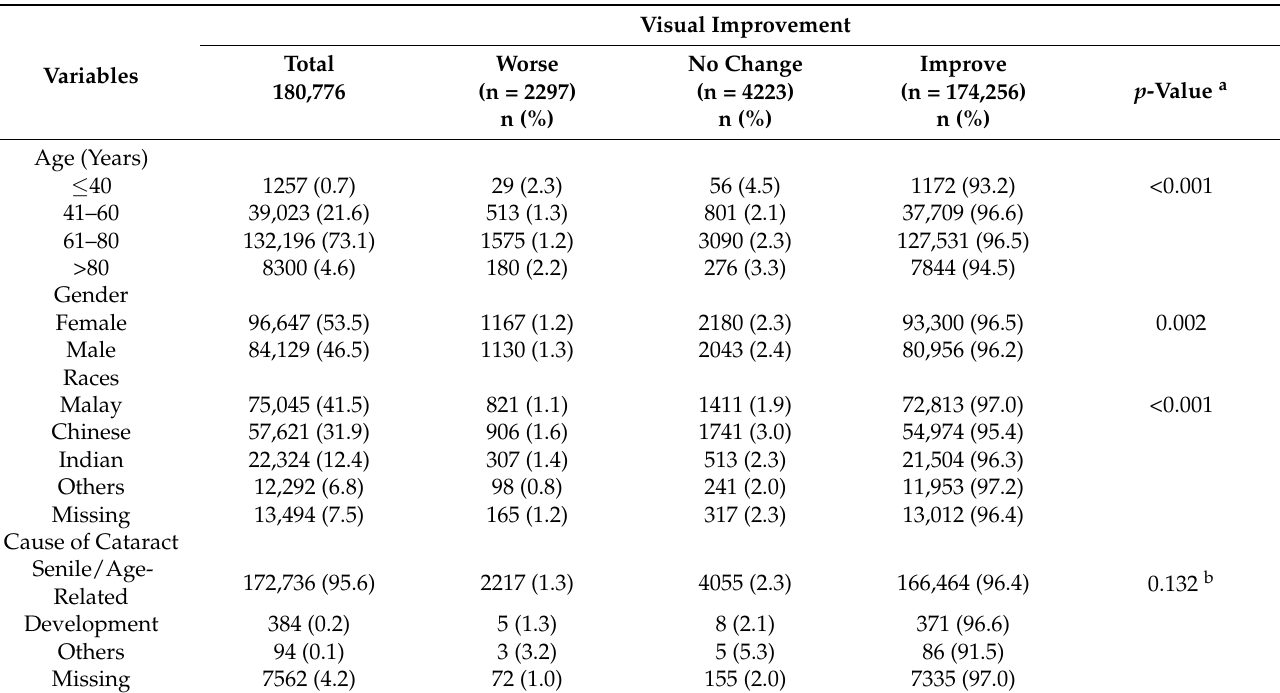
Table 2. Socio-demographic factors according to the level of improved